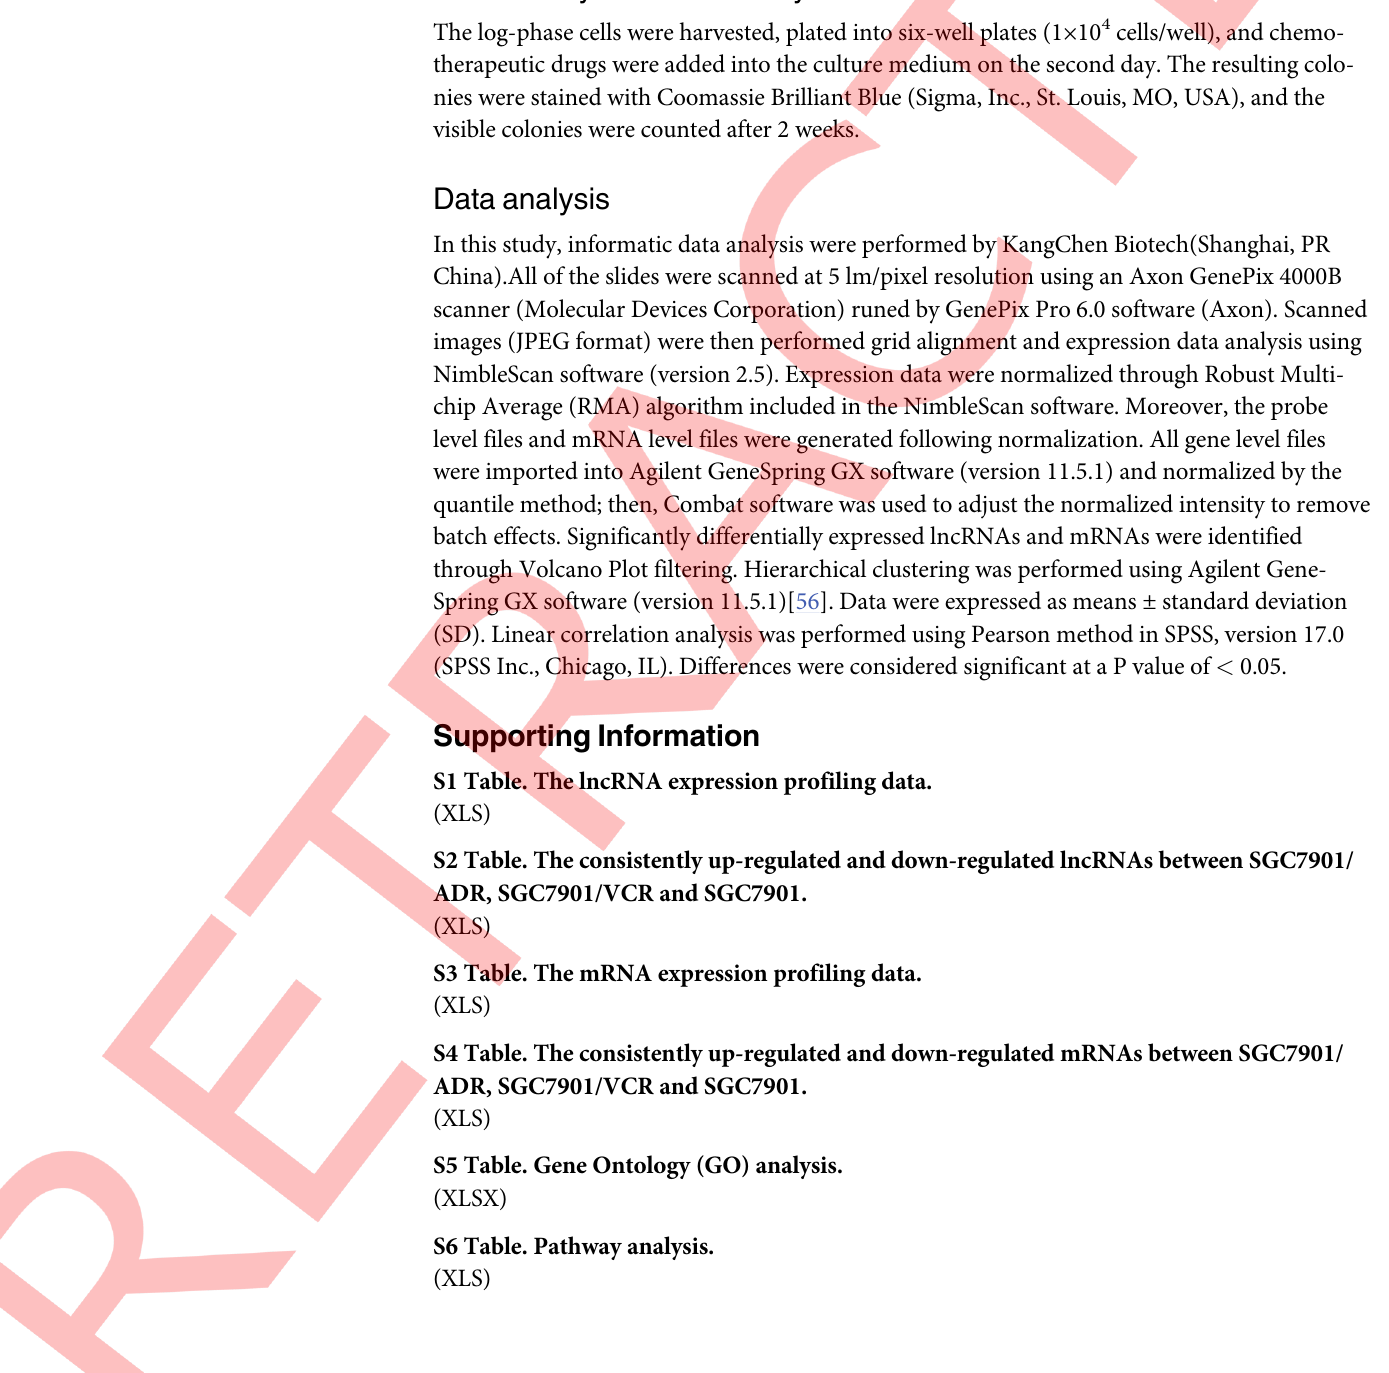
S5 Table. Gene Ontology (GO) analysis.